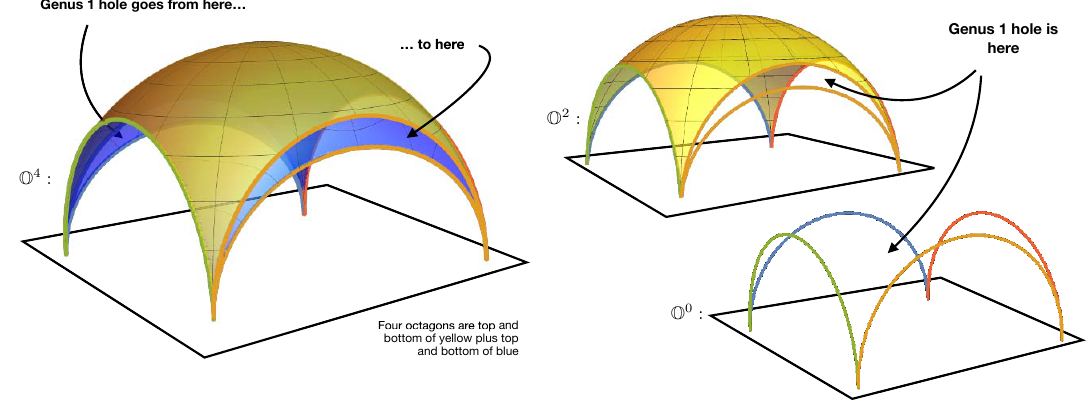
Figure 4 . AdS embeddings of the three graphs in figure 3. Each edge in figure 3 represents a bundle of ( √ N c ) propagators, and therefore becomes a heavy BMN geodesic connecting two O operators. These geodesics are folds of the worldsheet that connect adjacent octagons. The BPS octagons have no extent in AdS, they curl up along the BMN geodesics. The non-BPS octagons are extended objects that touch all four